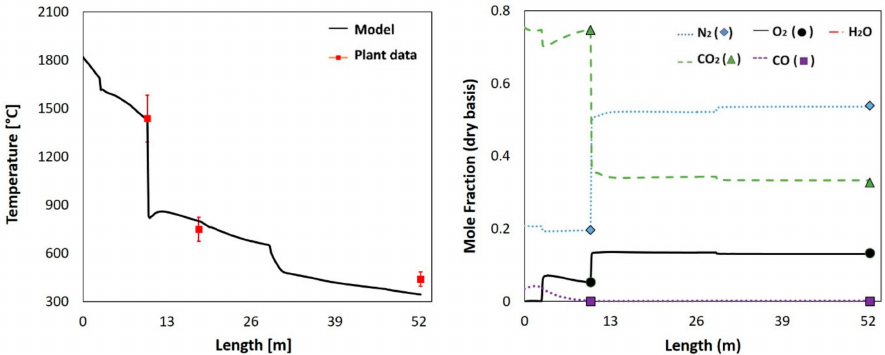
Figure 4. Calculated off-gas composition and temperature profile—model predictions (solid lines) and plant measured values (symbolled